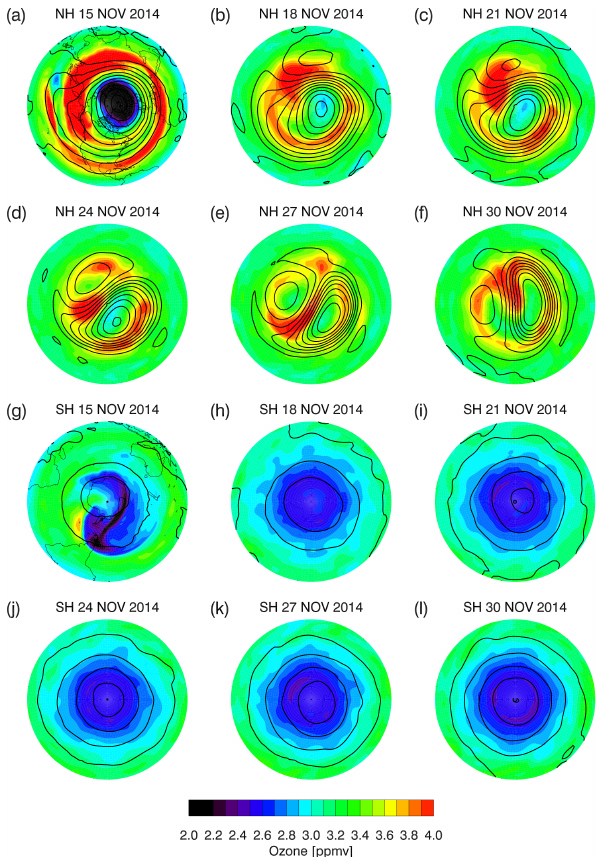
Figure 7. Maps of ozone (ppmv) (colors) at 1.1hPa ( ∼ 48km) over- laid with geopotential height (black lines) at 500m intervals for 15, 18, 21, 24, 27, and 30 November 2014 (all at 00:00Z). Panels (a– f) are NH and (g–l) are SH. Red (blue) contours indicated high (low) ozone values. Continent lines are placed on the maps for 15 Novem- ber.